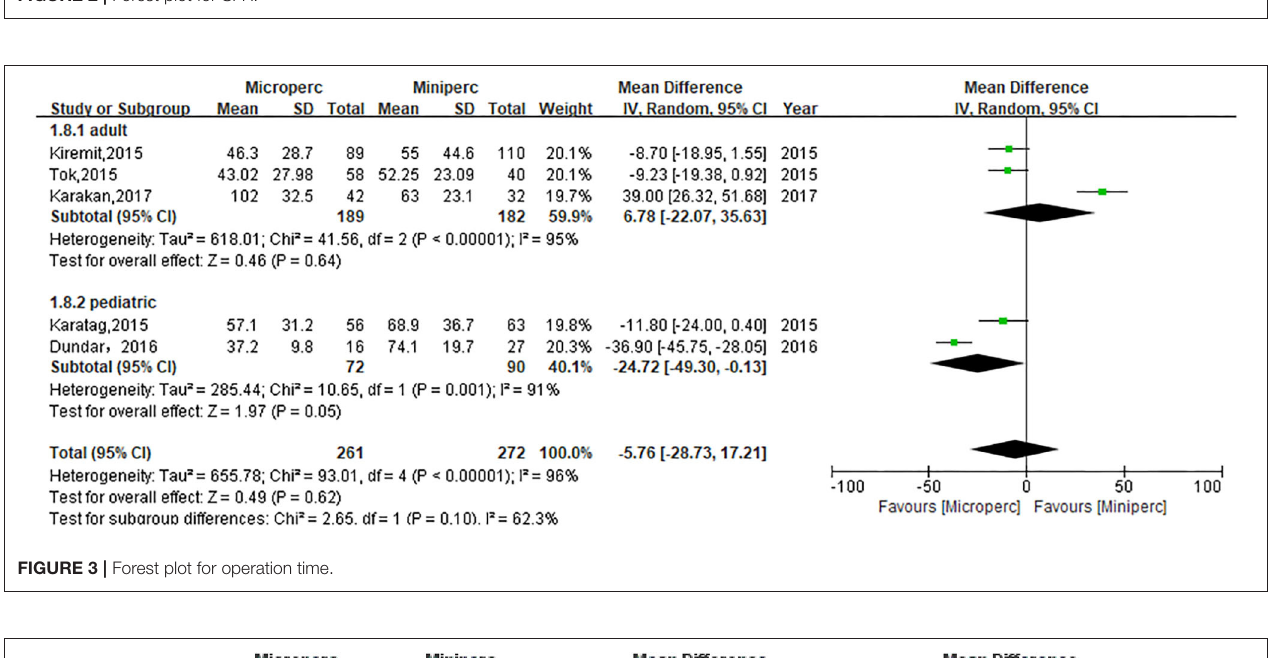
FIGURE 2 | Forest plot for SFR.